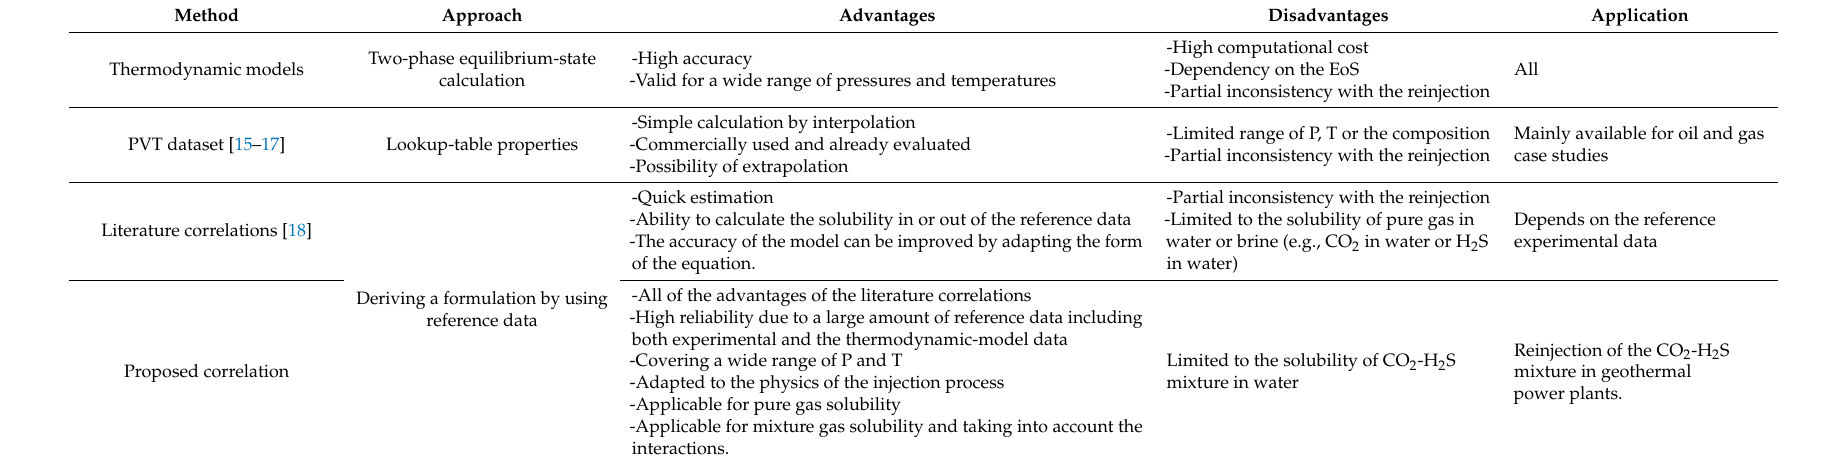
Table 1. Comparison of the solubility models subjected to the reinjection process in geothermal power